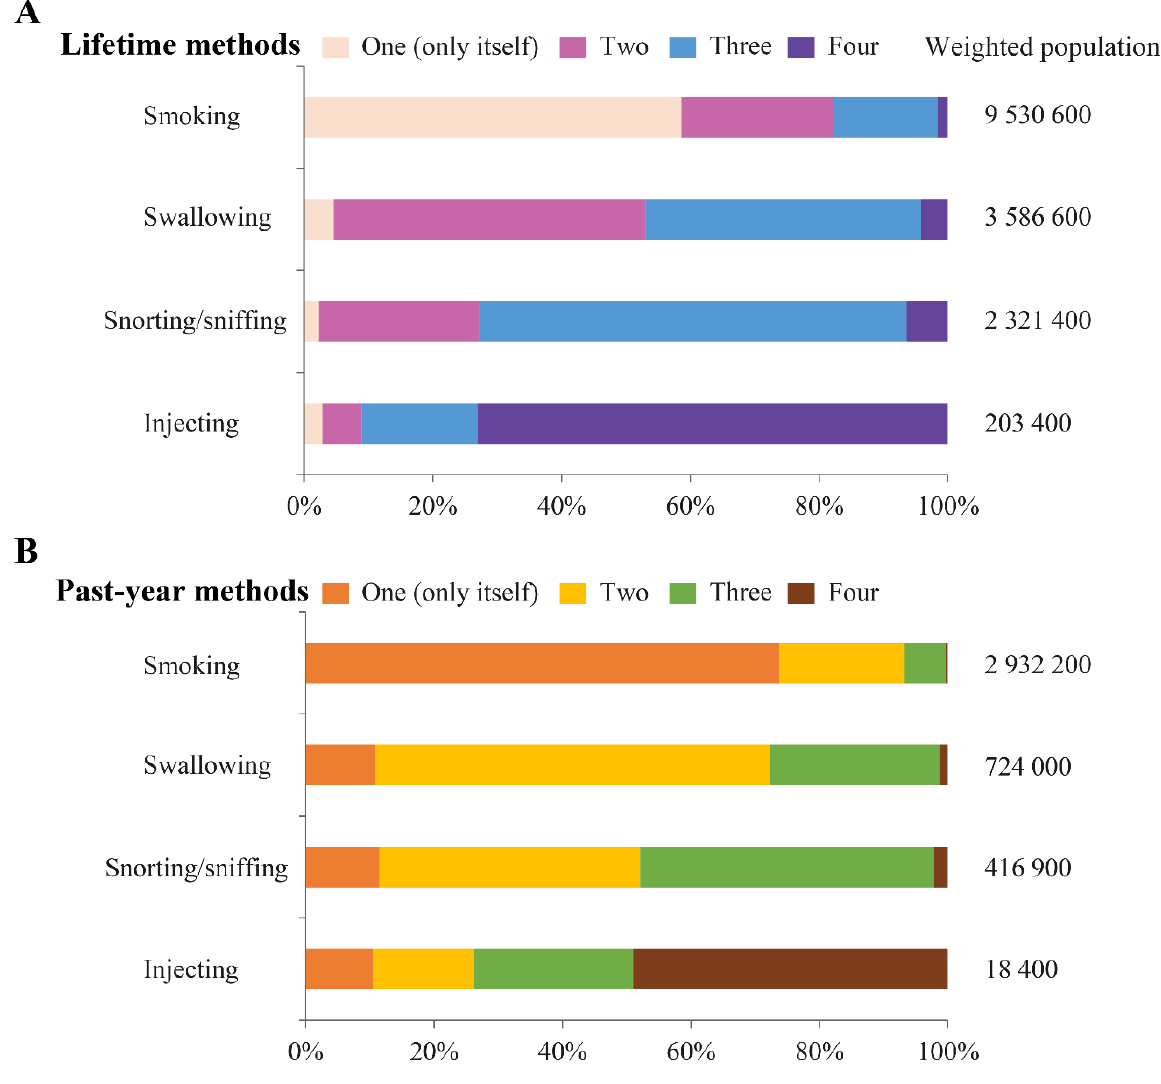
Figure 2. Patterns of lifetime ( A ), and past-year ( B ) illicit drug use methods. * Weighted numbers were rounded to base 100 for confidentiality purposes according to Statistics Canada data release